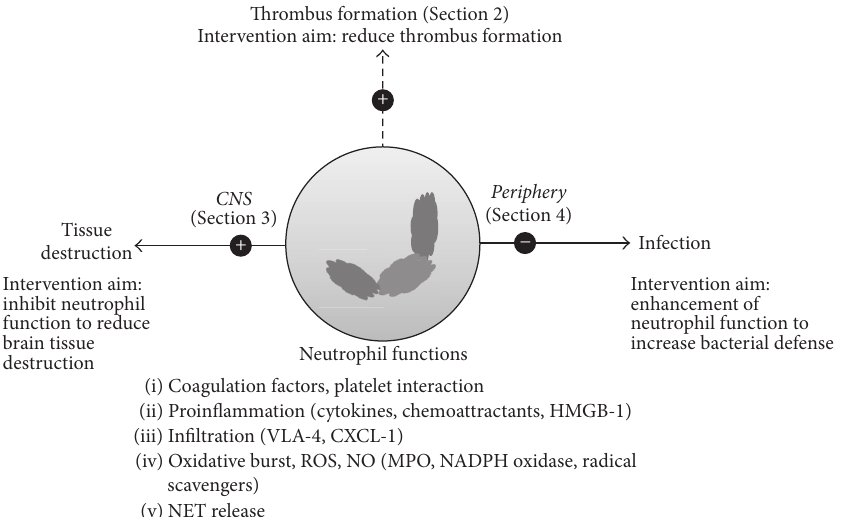
Figure 1: Neutrophil functions that can be targeted to reduce brain tissue destruction after stroke. Targets include factors involved in proinflammation, infiltration of immune cells, production of reactive oxygen species (ROS) and nitric oxide (NO), enzymatic functions of myeloperoxidase(MPO)andnicotinamideadeninedinucleotidephosphate(NADPH)oxidase,andthereleaseofneutrophilextracellulartrap (NET) components. Inhibiting these pathways may also reduce thrombus formation and prevent recurrent stroke. In addition, after a stroke, patients undergo poststroke immune suppression, which includes impaired oxidative burst and NET formation, induced by catecholamines. Enhancing bacterial defense by targeting these mechanisms could decrease the risk of secondary infections. Therefore, poststroke immune modulation must take into account the fact that immune suppression has opposing effects in the central nervous system and in the periphery. HMGB-1: high mobility group protein box 1; VLA-4: very-late-antigen 4; CXCL-1: chemokine (C-X-C motif) ligand